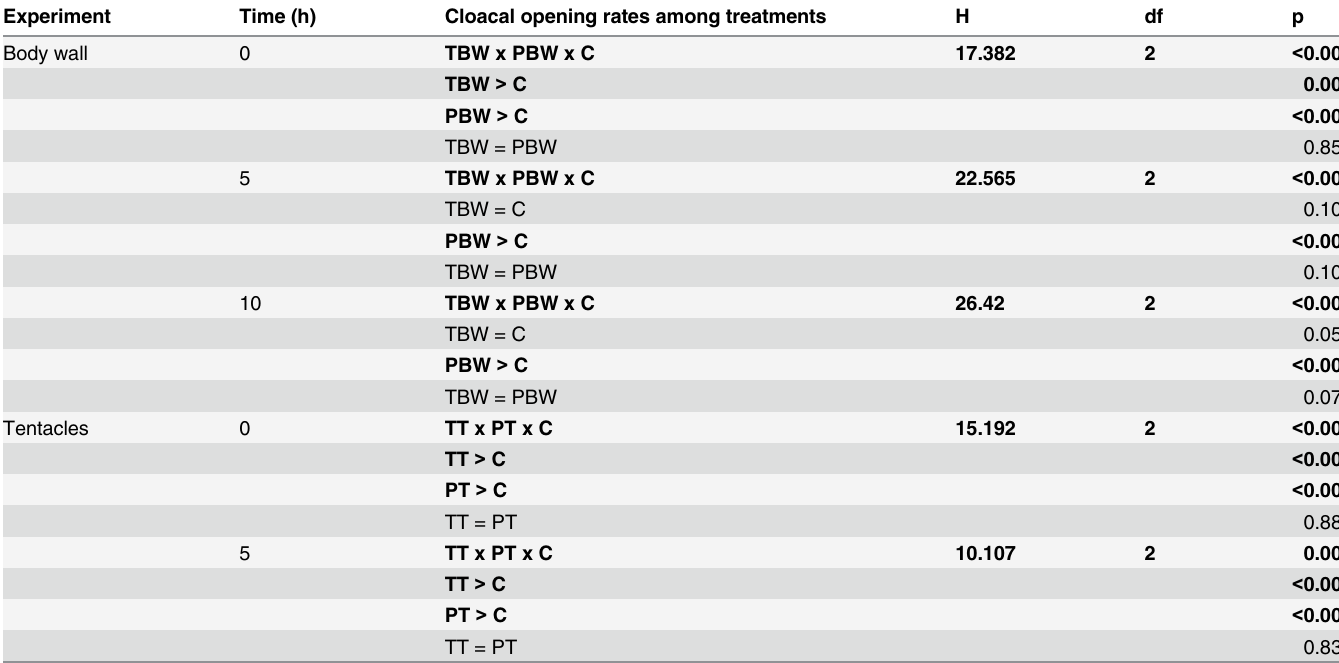
Table 4. Statistical comparison of cloacal movements (respiration rates) among